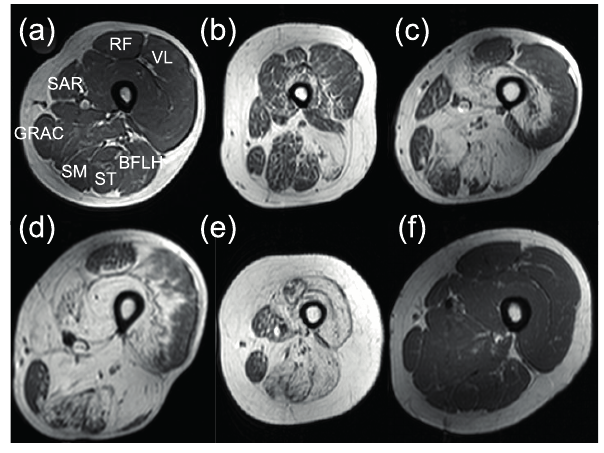
Figure 2. T1 weighted images of the thigh in LGMD2I patients with increasing stages of severity and fat content (a–e), and in a control subject (f). In (a) this is almost normal, however in (e) only sparing of gracilis and sartorius is seen. (VL= vastus lateralis, SM= semimembranosus, ST= semitendinosus, BFLH= biceps femoris long head, SAR= sartorius, GRAC= gracilis, RF= rectus